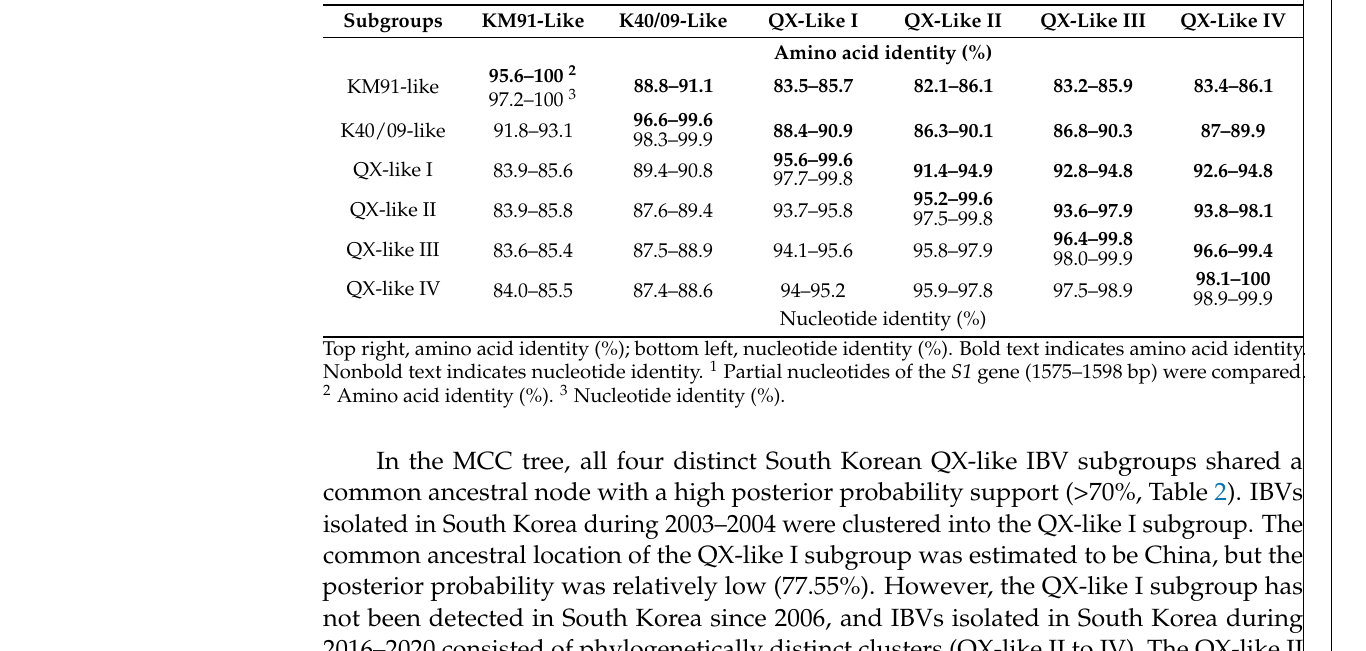
Table 1. Nucleotide 1 and amino acid identities of the S1 gene 1 between the South Korean GI-19 IBVs.